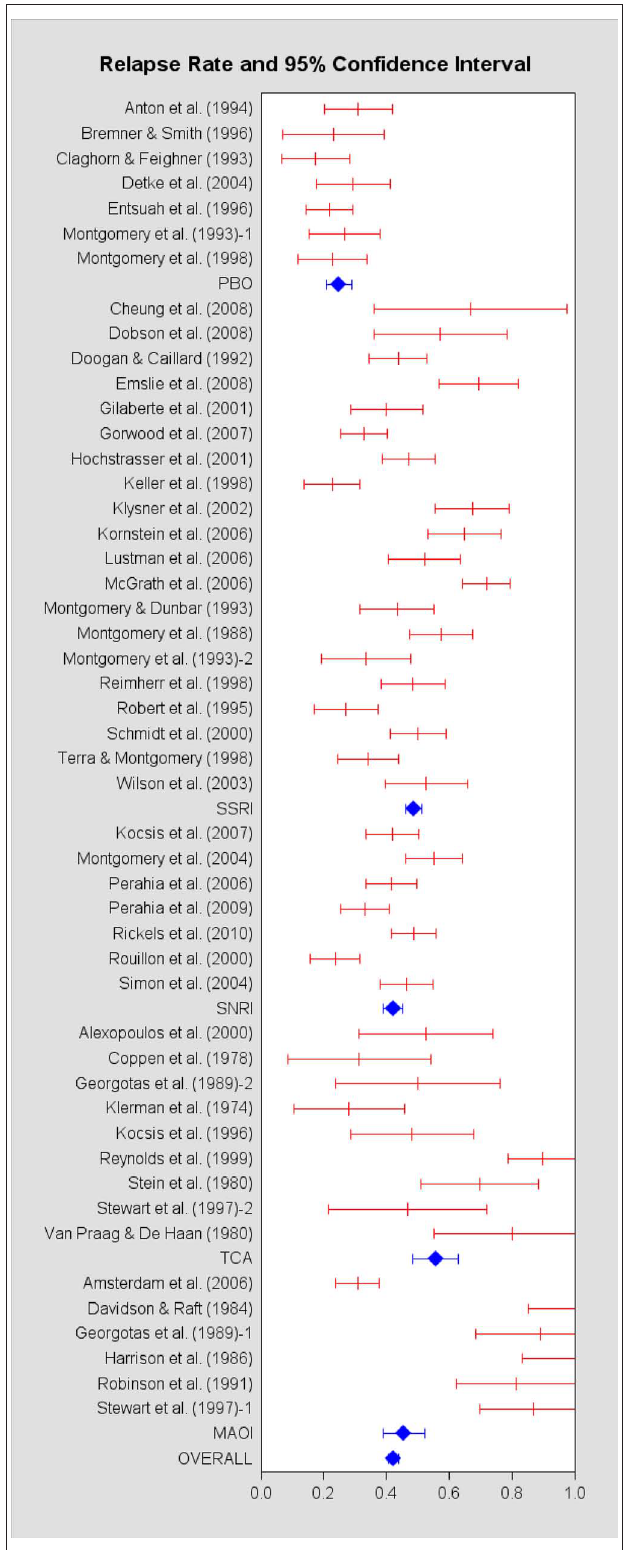
FiguRE 2 | Forest plot of the relapse rate and 95% confidence interval for each study meeting inclulsion